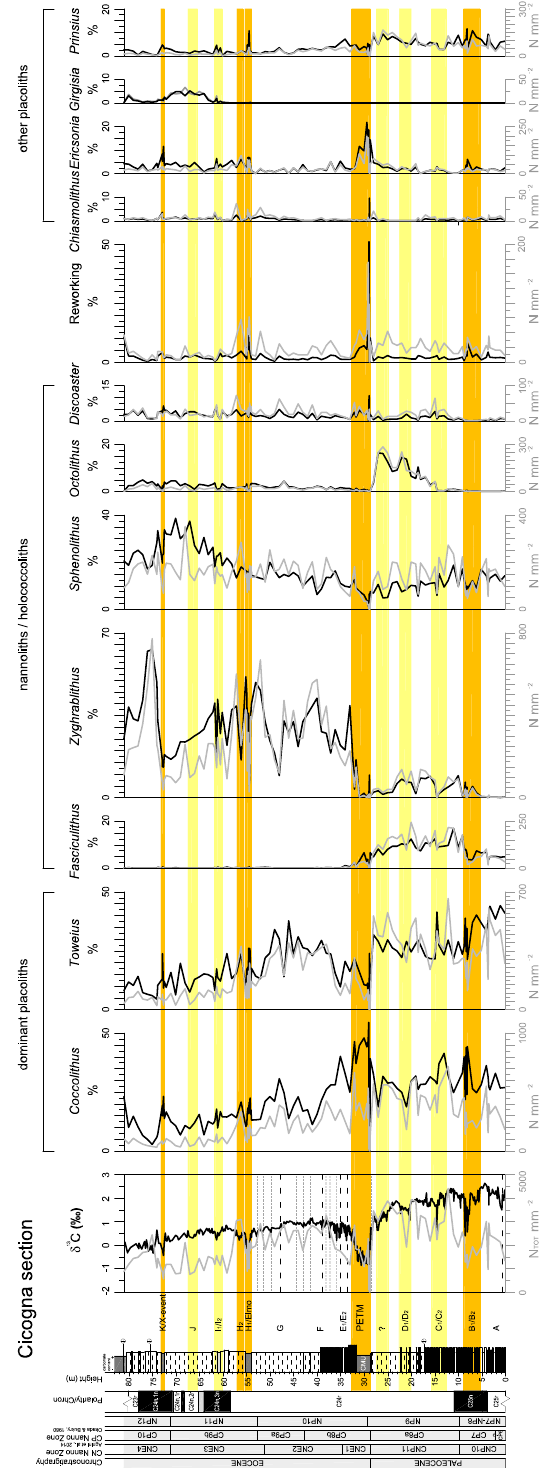
Figure 7. Relative (%) and semi-quantitative (Nmm − 2 ) abun- dances of selected calcareous nannofossil genera across the Cicogna section. Also shown are the lithostratigraphy, magnetostratigraphy, biostratigraphy and carbon isotope ( δ 13 C) stratigraphy at the Ci- cogna section (Fig. 4). Color bands and symbols are the same as in previous